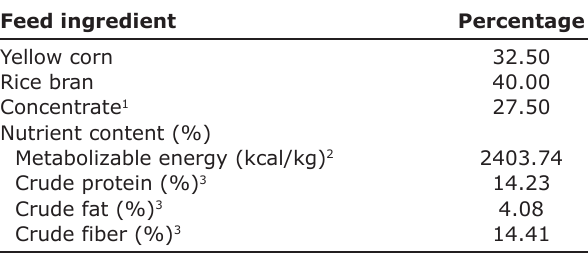
Table-1: Composition of feed ingredient and nutritional content of “farmer